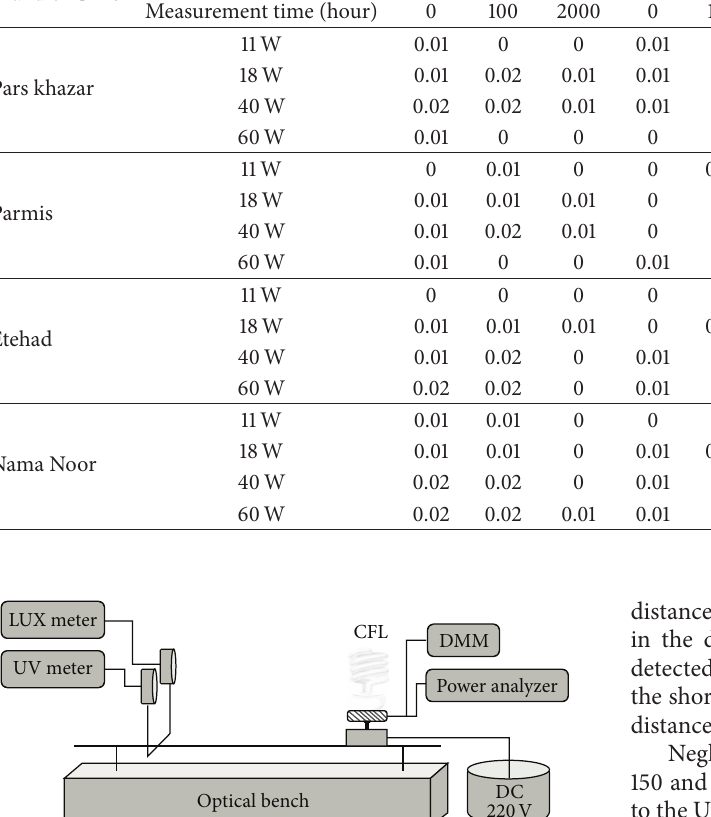
Table 1: UVB irradiance (W ⋅ m − 2 ) in different times for four brand CFLs at 90 ∘ in Iranian brands. Brand of CFLs